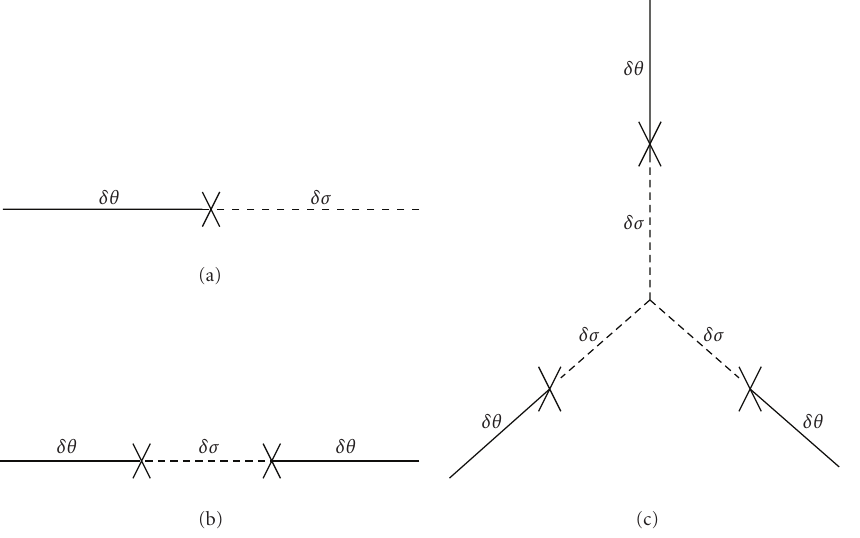
Figure 13: Feynman diagrams for the transfer vertex (a), corrections to the power spectrum from isocurvature modes (b), and the leading bispectrum